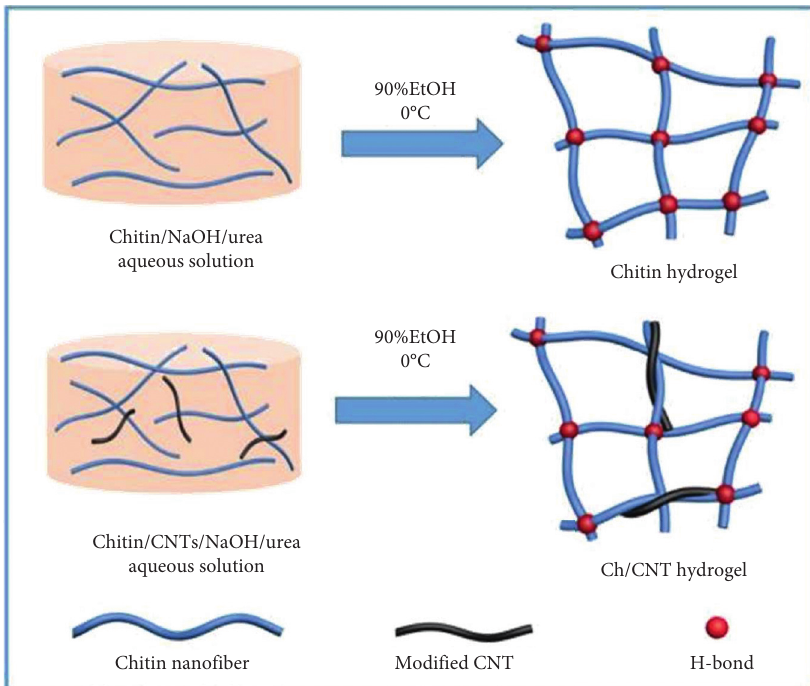
Figure 9: Schematic representation of the synthesis process of chitin-MWCNT hydrogel hybrids